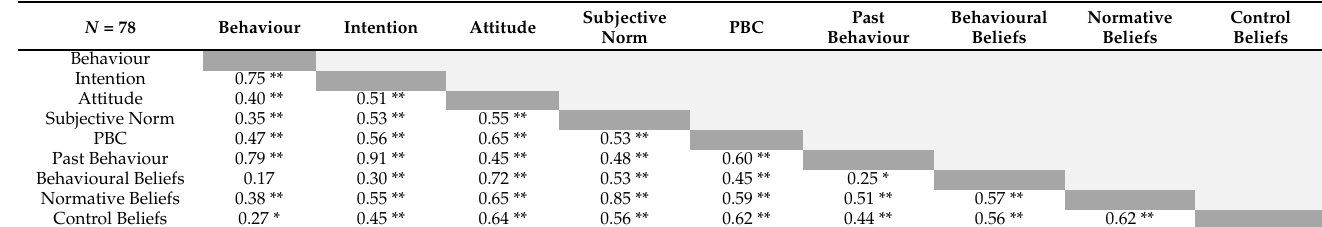
Table 6. Pearson correlations (r) between